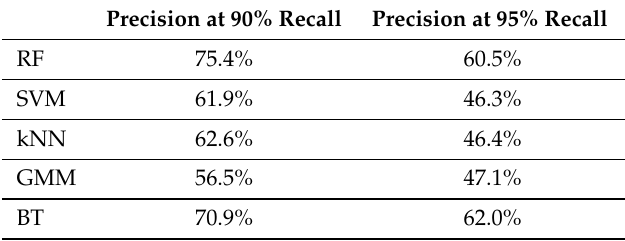
Table 2. Best Result for Each of the Tested Classifiers with Colour Features.